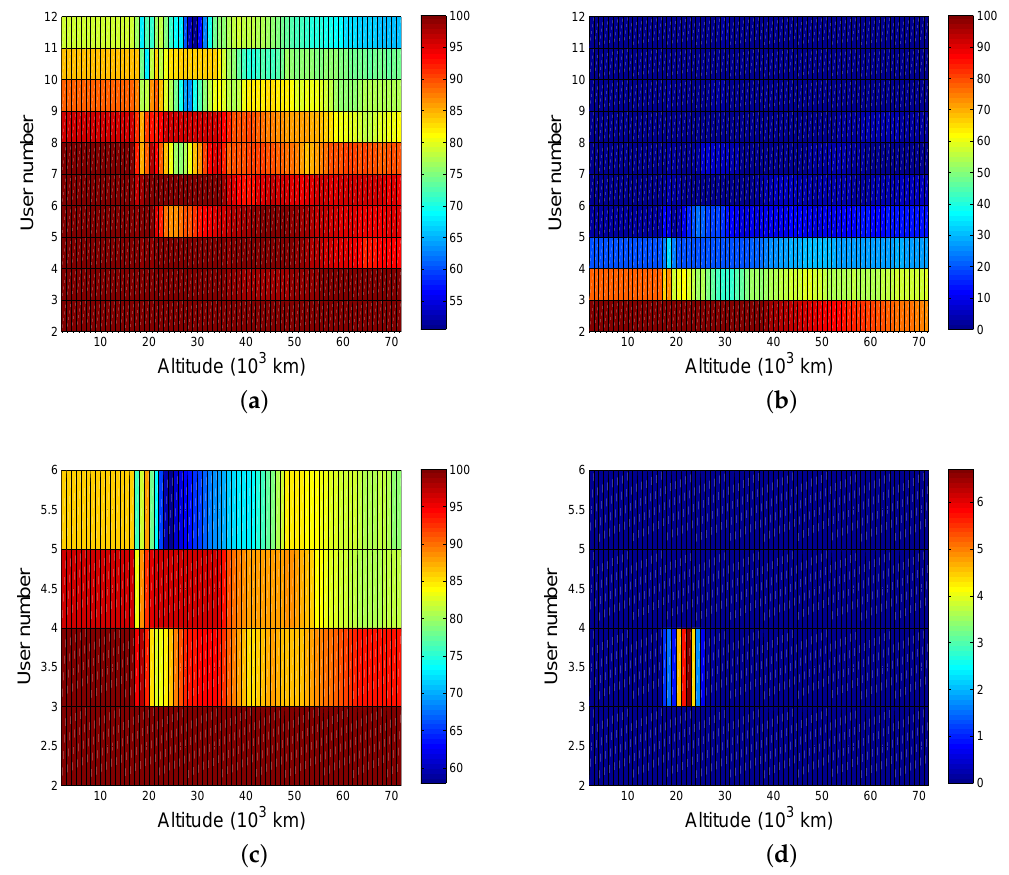
Figure 11. The available probability of SSMT (the worst user): ( a ) one or more (12 satellites); ( b ) four or more (12 satellites); ( c ) one or more (six satellites); and ( d ) four or more (six satellites).